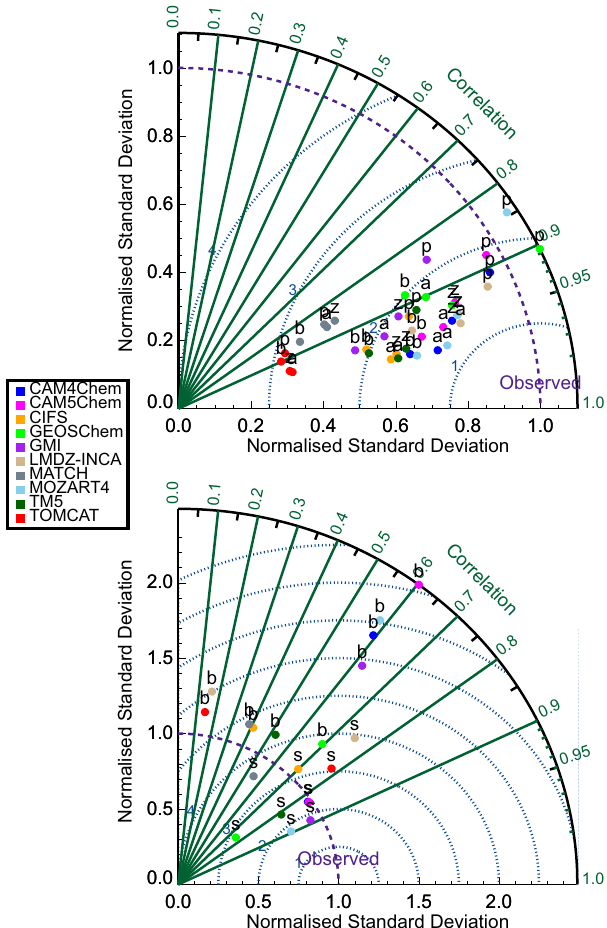
2.0 Normalised Standard Figure 3. Taylor diagrams for Arctic surface comparisons of monthly mean time series of CO (left) and O 3 (right). The letters represent the first letter of the station codes shown in Fig. 1 (a– Alert, b–Barrow, p–Pallas, s–Summit, z–Zeppelin). (Taylor dia- grams show the extent to which models capture the observed vari- ability (by the normalised standard deviation (NSD), shown by pur- ple dashed contour), month-to-month changes in concentration (by the correlation ( r ), shown by green solid lines) and the mean model bias as a function of the variations around the annual mean (by (cid:54) n = 1 , 12 (m n − the centred root-mean-square difference (RMSD= 1 n ¯ m) − (o n − ¯ o) ), shown by the blue dotted contours). Perfect agree- ment between a model and observations would result in a NSD of 1, a correlation of 1 and a RMSD of 0, which is indicated by “Ob- served” on the Taylor diagram.)